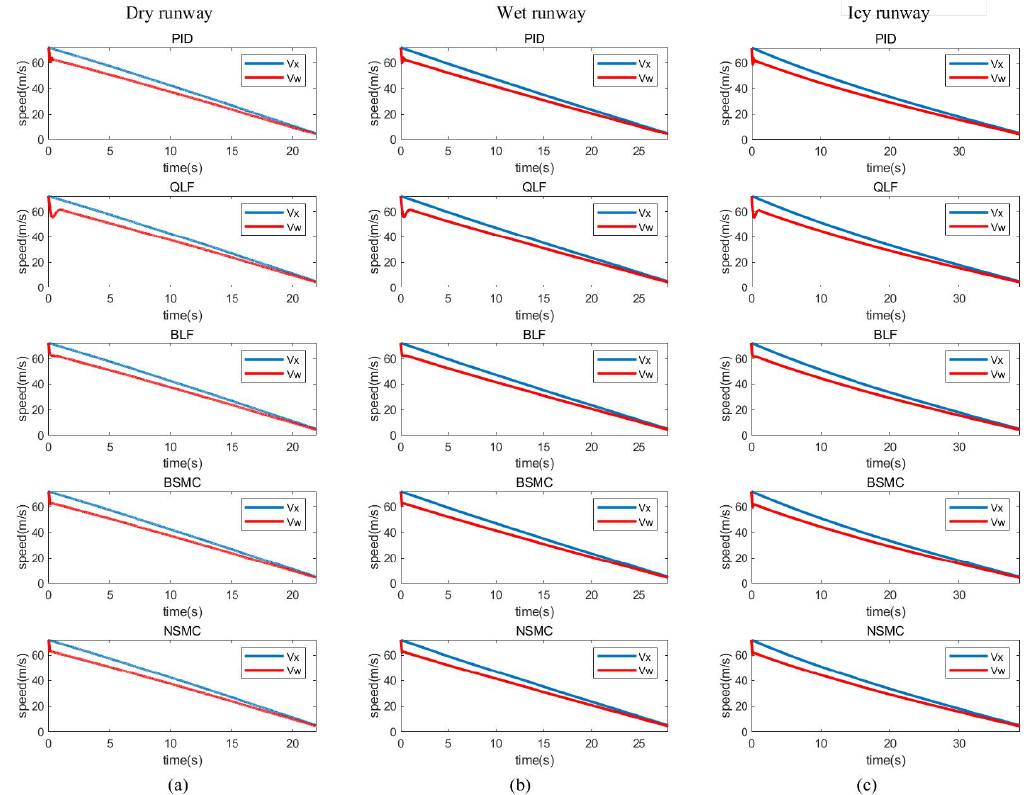
Figure 6. Aircraft longitude speed and wheel line speed of different algorithms in three runways. The three-column graphs ( a – c ) represent dry, wet, and icy runway conditions, respectively. The five-line graphs represent the simulation results under the traditional PID control algorithm, the control algorithm based on the quadratic Lyapunov function, the control algorithm based on the barrier Lyapunov function, and the traditional sliding mode controller, the sliding mode controller based on novel reaching law. For example, the subplots in the first row and first column represent the results of an aircraft braking control simulation using a conventional PID controller in a dry runway